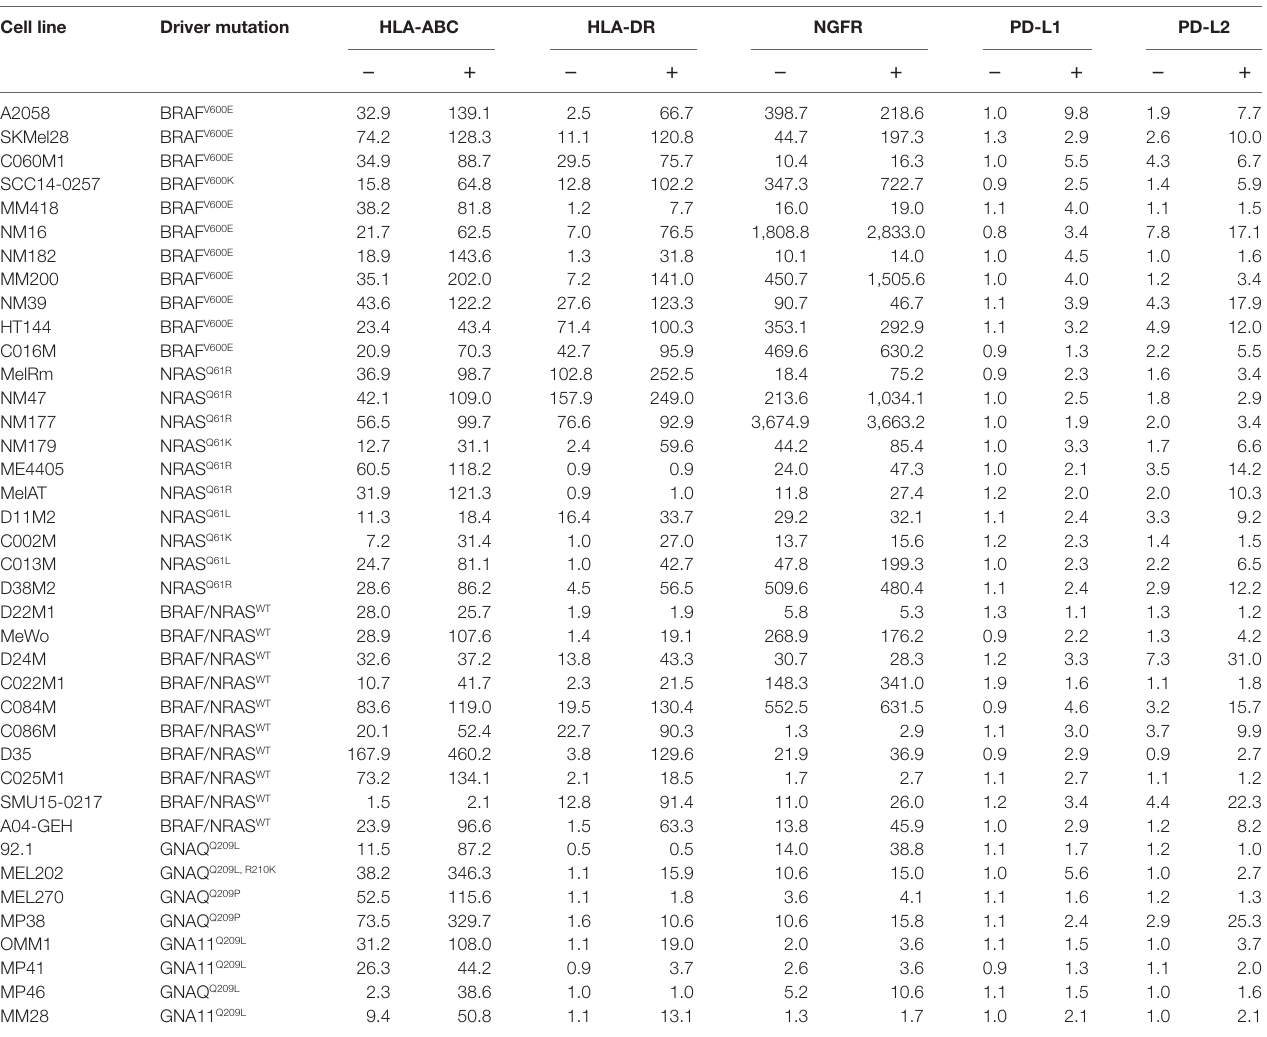
TaBle 1 | Expression of IFN γ -target proteins at baseline and post-stimulation with IFN γ in 39 melanoma cell lines. cell line Driver